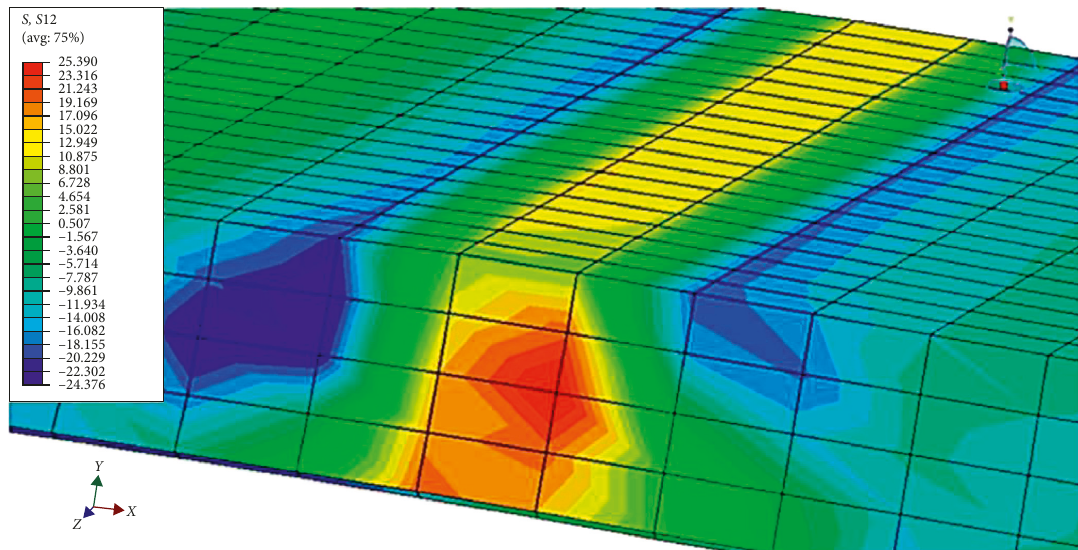
Figure 16: Distribution of tangential contact stresses in a thermal deformation hearth at K